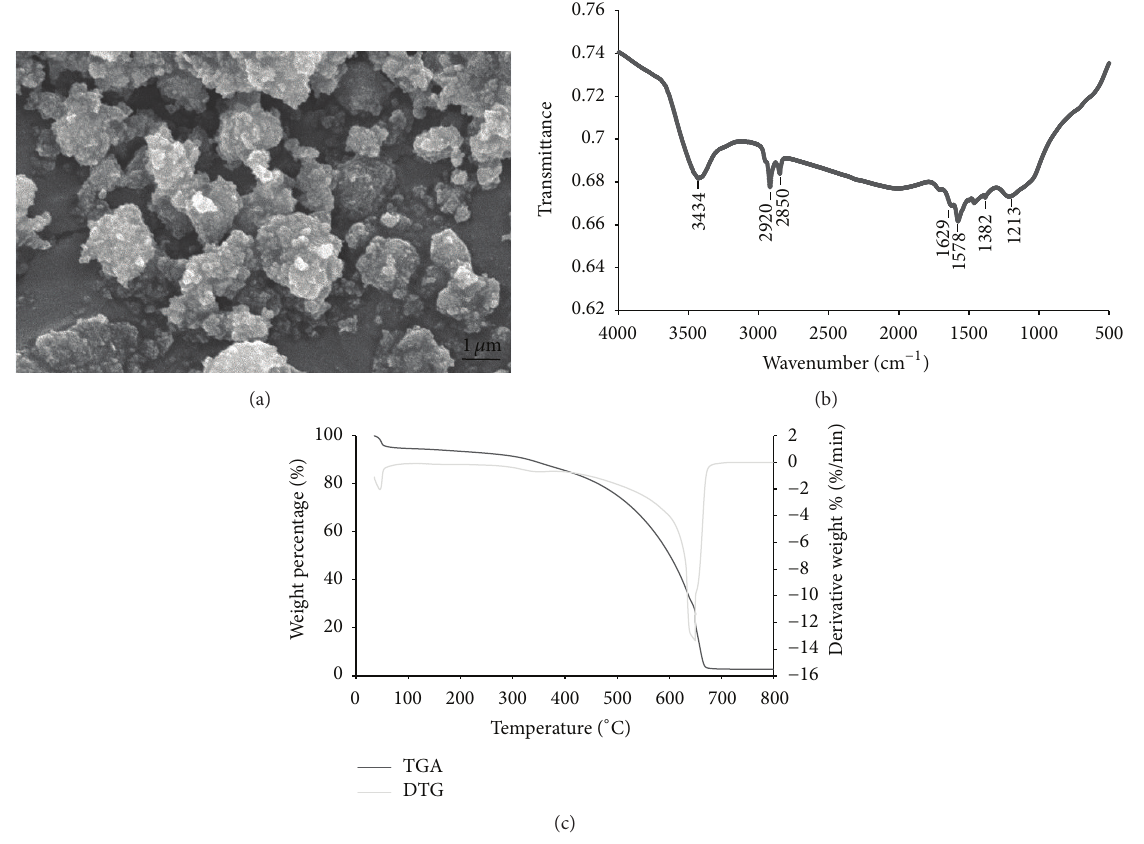
Figure 1: (a) SEM micrograph of GNP powder; (b) FTIR spectra; and (c) TGA and DTG curve of raw GNP.